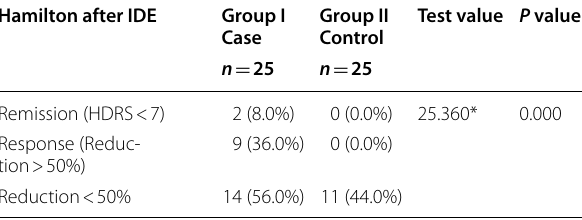
Table 4 Comparison between group I and group II regarding